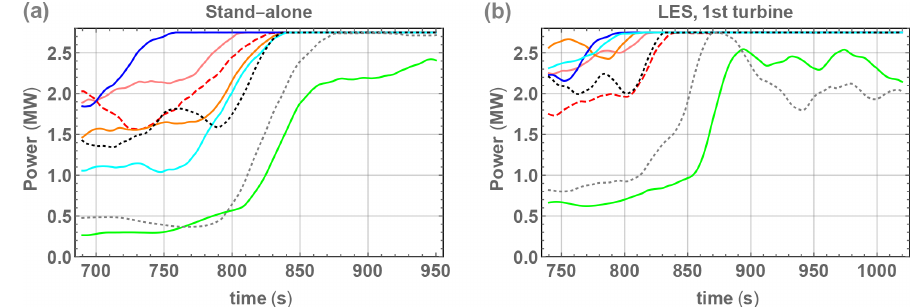
Figure 14. Power output through all simulated ramp events of the ensemble. (a) Stand-alone Flex5 simulations driven by CMM. (b) CMM- LES-Flex5 simulated power, for first (upwind)